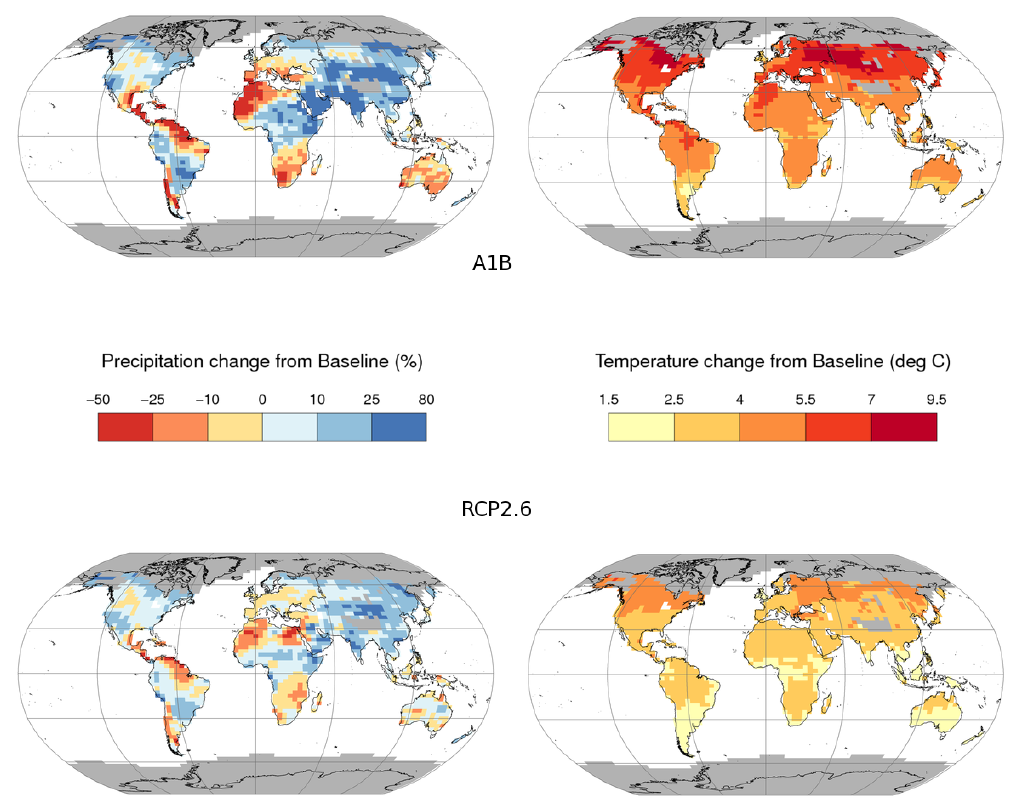
Fig. 4. Precipitation (left panels) and temperature (right panels) anomalies for the 2080s (1970–2099) from the baseline 1961–1990 for the exemplar model of the ESE for A1B (top panels) and RCP2.6 (bottom panels) future scenarios. Grey regions represent the excluded cold